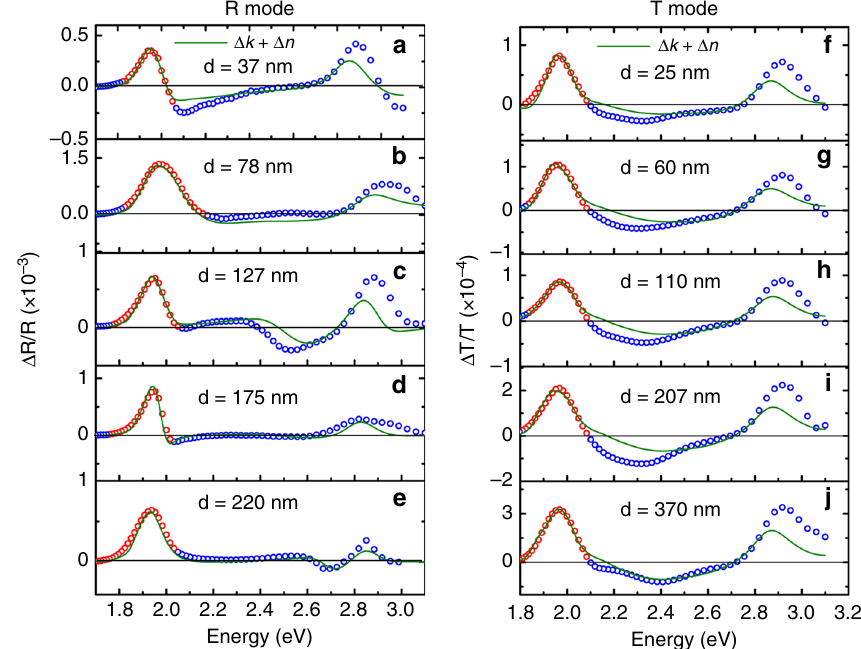
Fig. 8 Analytical electromodulation fi tting. a – e Re fl ection mode electromodulation (EM) spectrum fi tted with analytical model considering both modulation of absorption coef fi cient and refractive index. Devices ( a ) to ( e ) correspond to the same devices as in Fig. 3 ( a ) to ( e ), and the thickness refers to the thickness of the active layer used in optical simulation. f – j Transmission mode EM spectrum fi tted with analytical model considering both modulation of absorption coef fi cient and refractive index. Devices ( f ) to ( j ) correspond to the same devices as in Fig. 3 ( f ) to ( j ), and the thickness refers to the thickness of the active layer used in optical